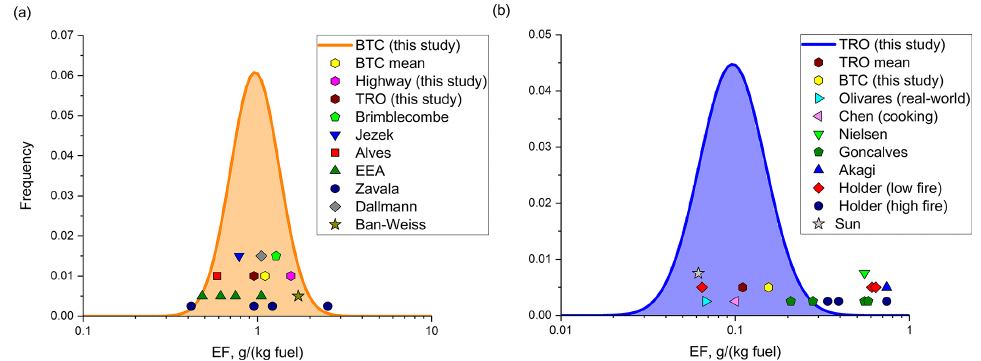
Figure 8. Distribution of the transformed FF EFs referring to the diesel emission at the BTC location (a) . Scatter points show average EF data from the literature and the highway measurement (only X axis concerned). (b) Distribution of the BB EFs at the TRO location. Scatter points show average EF data from the literature and the BTC result (only X axis concerned). See more details in Table 6.